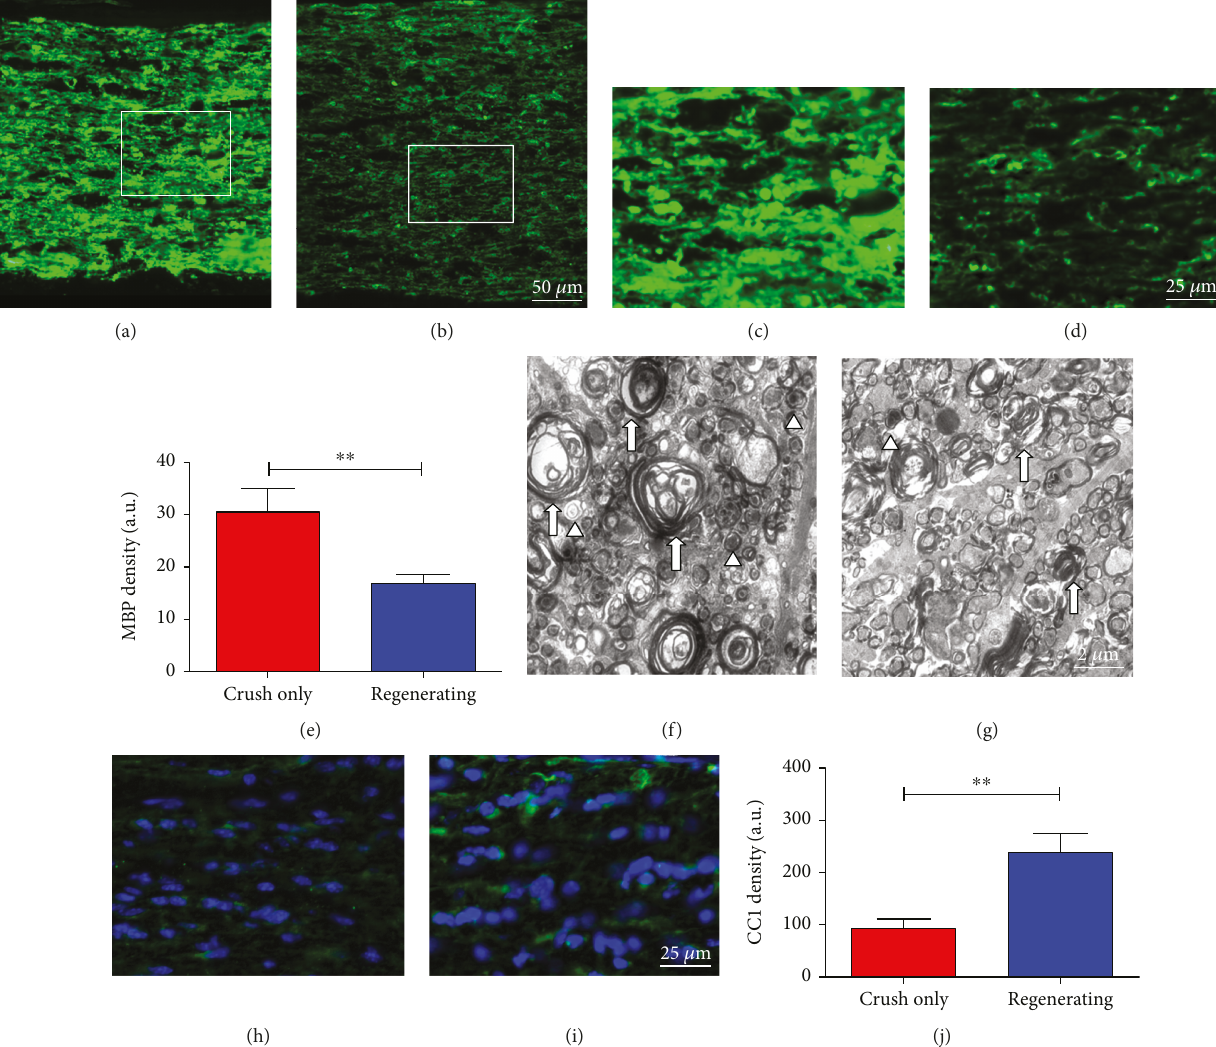
Figure 2: Myelin content within the optic nerve. (a – d) MBP labeling (green) two weeks after optic nerve injury. (a and c) Optic nerve from the Crush-only group exhibiting large amount of MBP staining compared to (b and c) optic nerve from the Regenerating group. (e) Quanti fi cation of MBP levels. (f, g) EM images showing myelin debris in both groups. Arrows point to myelin debris, whereas arrowheads indicate degenerating nerve fi bers; (h – j) CC1 staining (green) two weeks after optic nerve injury; (h) optic nerve from the Crush-only group exhibiting a reduced CC1 staining; (i, j) optic nerve image and quantitative analysis showing a higher density of CC1 staining in the Regenerating group. N = 5 per group. Scale bars: (a, b) 50 μ m; (c, d) 25 μ m; (f, g) 2 μ m; (h, i) 25 μ m. Error bars in (e) and (j) show SEM. ∗∗ P < 0 01